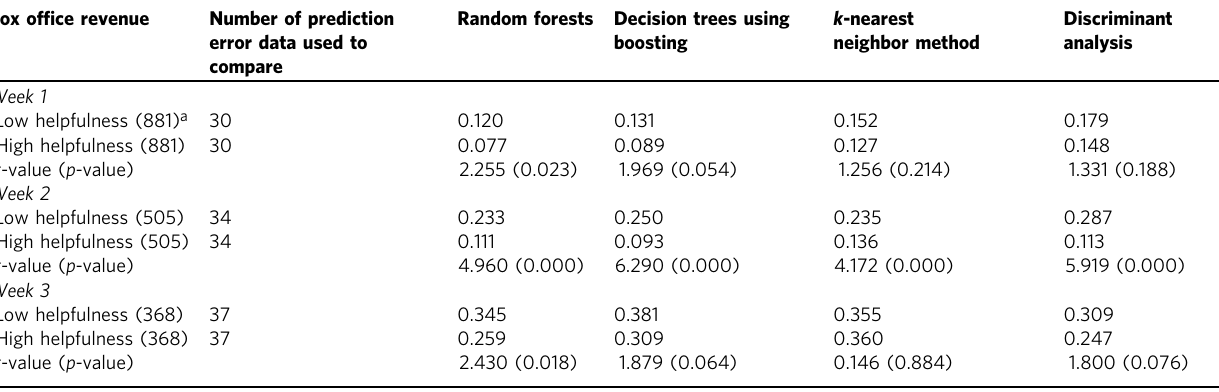
Table 9 Average prediction error among machine learning methods for high and low review helpfulness groups.